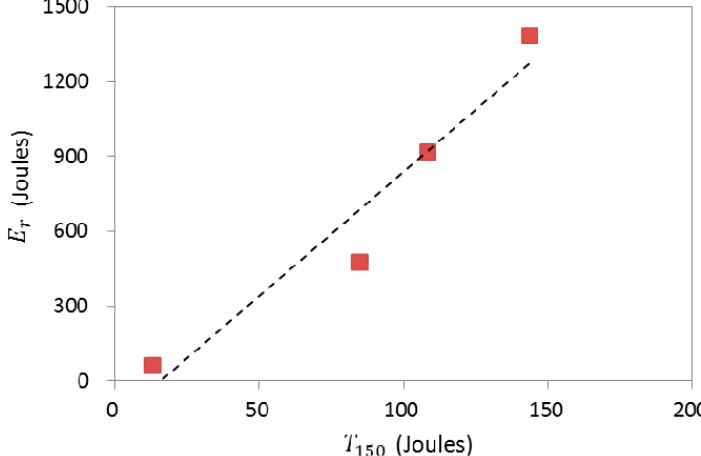
Figure 17. Relationship between the energy absorption capacity E r of the anchor and the energy absorption capacity T 150 of the beam.